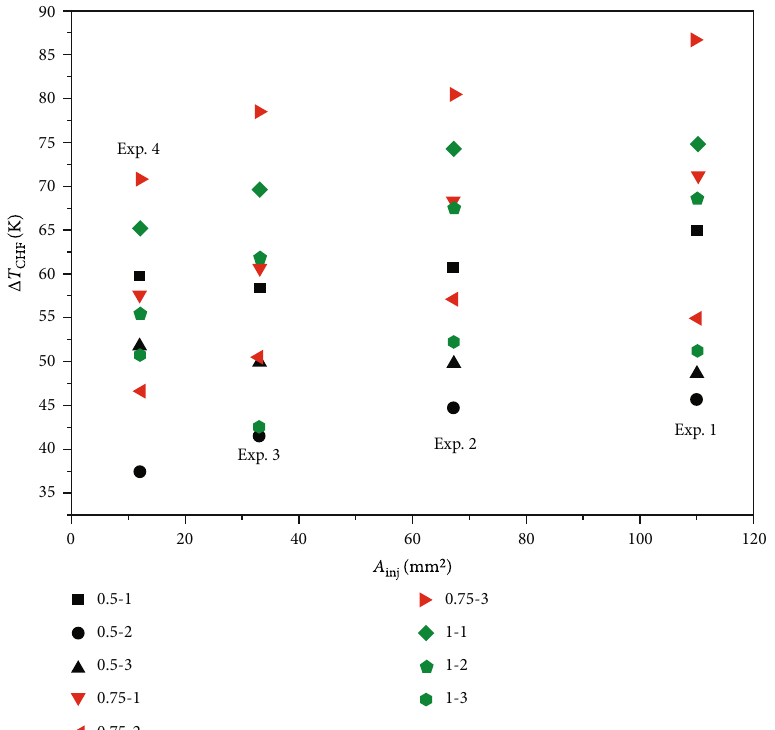
Figure 17: Experimental Δ T